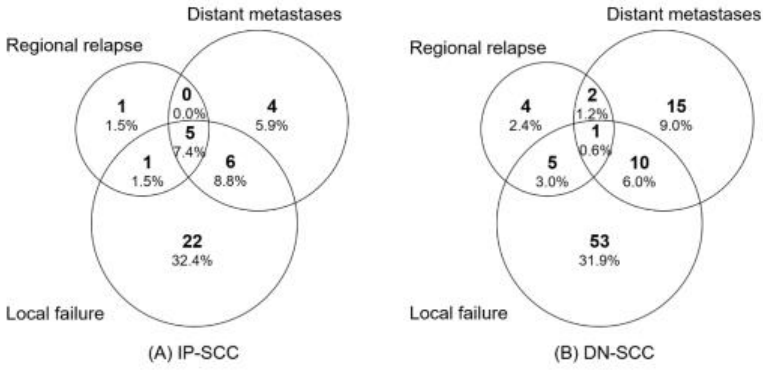
Figure 3. The failure patterns of IP-SCC and DN-SCC.